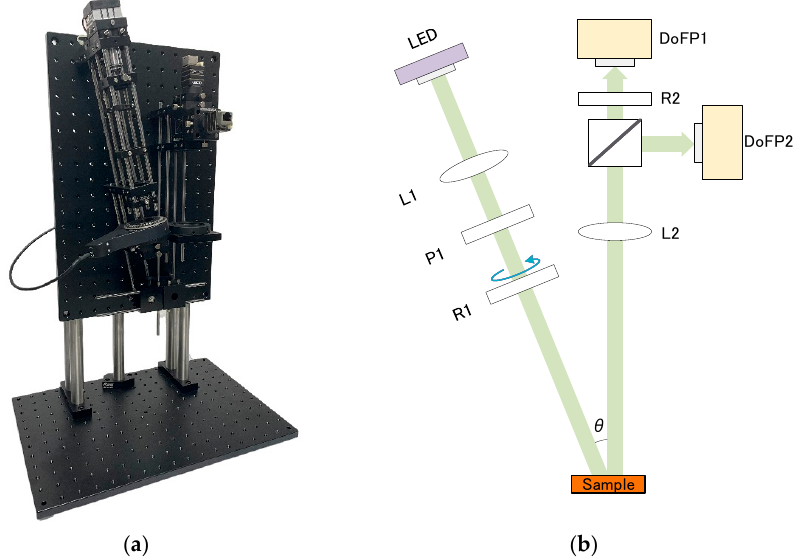
Figure 1. Photograph ( a ) and configuration ( b ) of the fast-backscattering Mueller matrix system based on dual division of focal plane (DoFP) polarimeters.